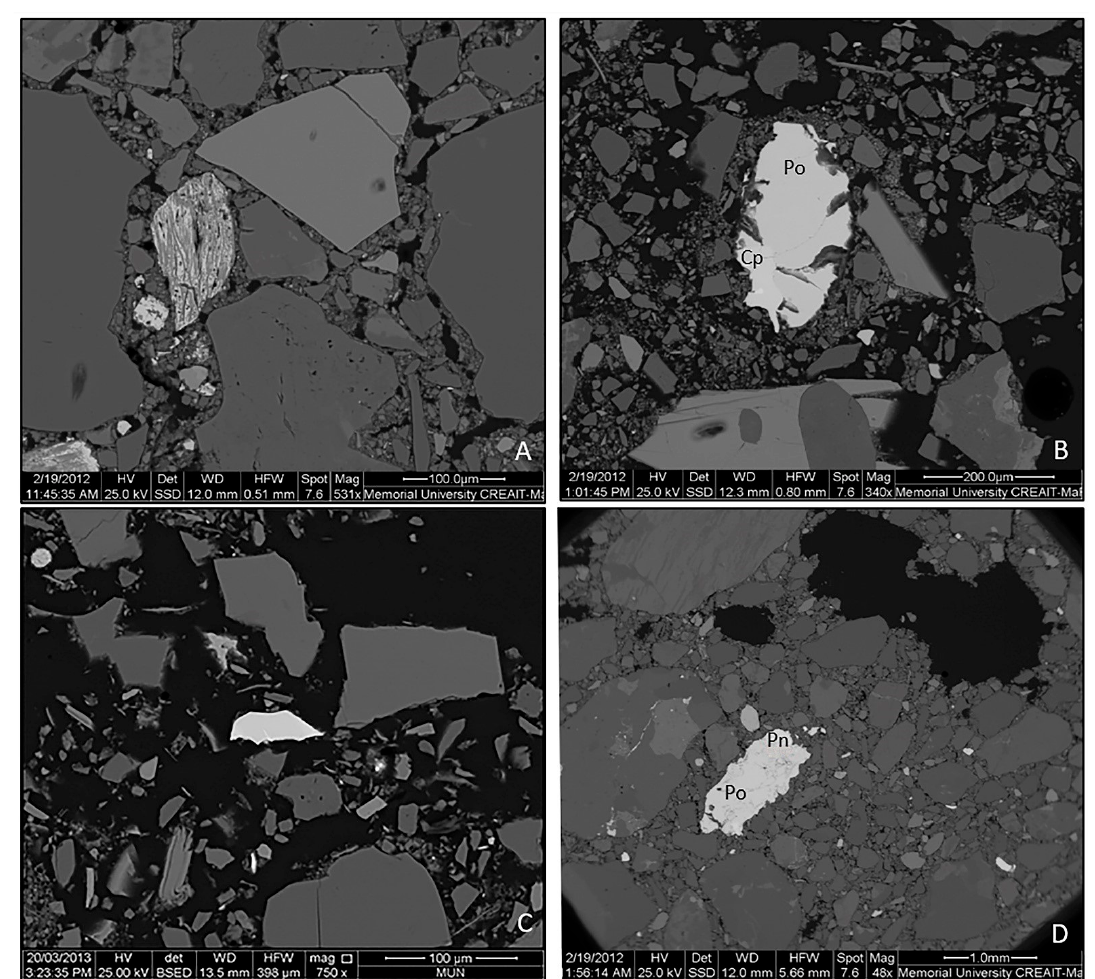
Figure 13. BSE images of polished grain mounts of till from split spoon samples, Voisey’s Bay: ( A ) highly oxidized pentlandite (Pn) grain (sample GTT11-13-25 m), ( B ) corroded large pyrrhotite (Po) and chalcopyrite (Ccp), Ccp has sphalerite inclusion (bright), sample GTT11-13-32.6m, ( C ) Po grain with exsolved Pn (bright) in sample GTT11-13-31m, and ( D ) large Po grain with intergrown Pn in sample GTT11-13-